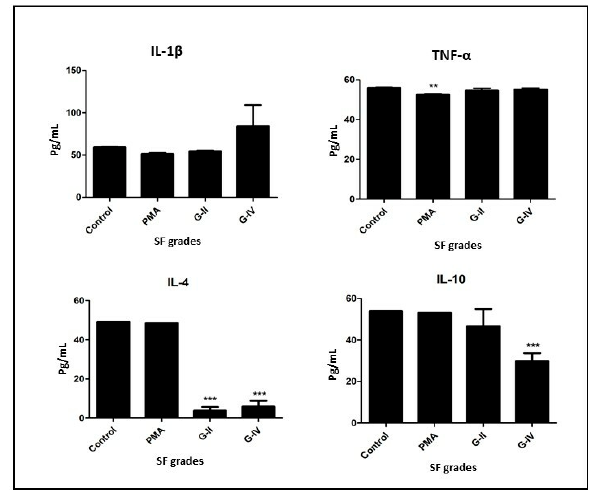
Figure 5. Functional status of the newly differentiated cells from in vitro PBMC-derived CD14+ cells was investigated by estimating cytokine levels in the cell culture media after 48 h of SF induction; in the figure, the X-axis denotes different KL grades of SF samples used for the induction, while the Y-axis represents the level of each selected cytokine in pg/mL; in the selected cytokines panel, IL-1 β and TNF- α are M1-macrophage-specific, and IL-4 and IL-10 are M2-specific cytokines; * p < 0.05, ** p < 0.01, *** p < 0.001, as compared to control.